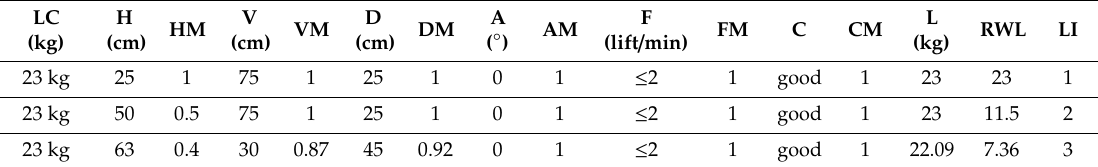
Table 1. NIOSH protocol values for each lifting task are